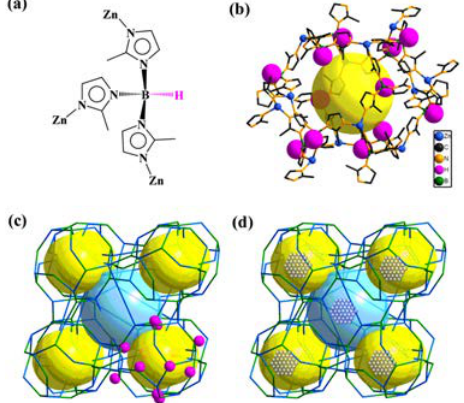
Figure 8. ( a ) The coordination mode of BH(mim) 3 − ligand; ( b ) the rich B–H bonds. (H atoms bonded to B centers are highlighted as purple balls) in the SOD cage of BIF-20; ( c ) the interrupted LTA-type framework of BIF-20, showing large cavities represented by the yellow and sky-blue balls; and ( d ) a schematic representation of the loading of NPs into the cavities of BIF-20. Reprinted with permission from Reference 77.